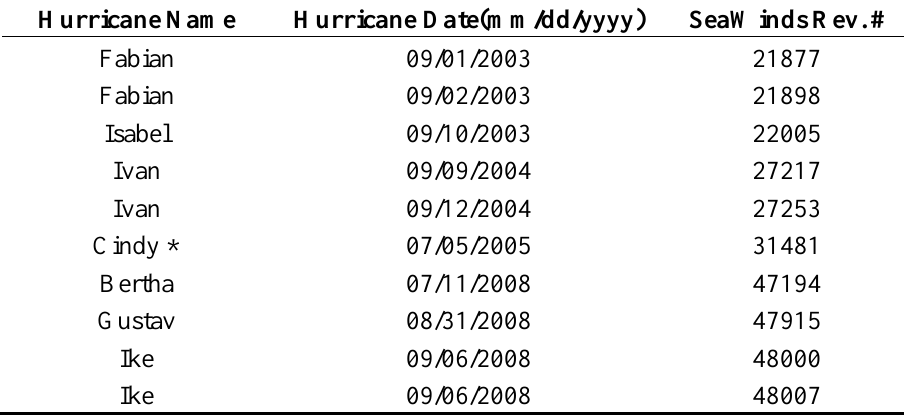
Table 1. QuikSCAT hurricane overpasses used to evaluate X-Winds